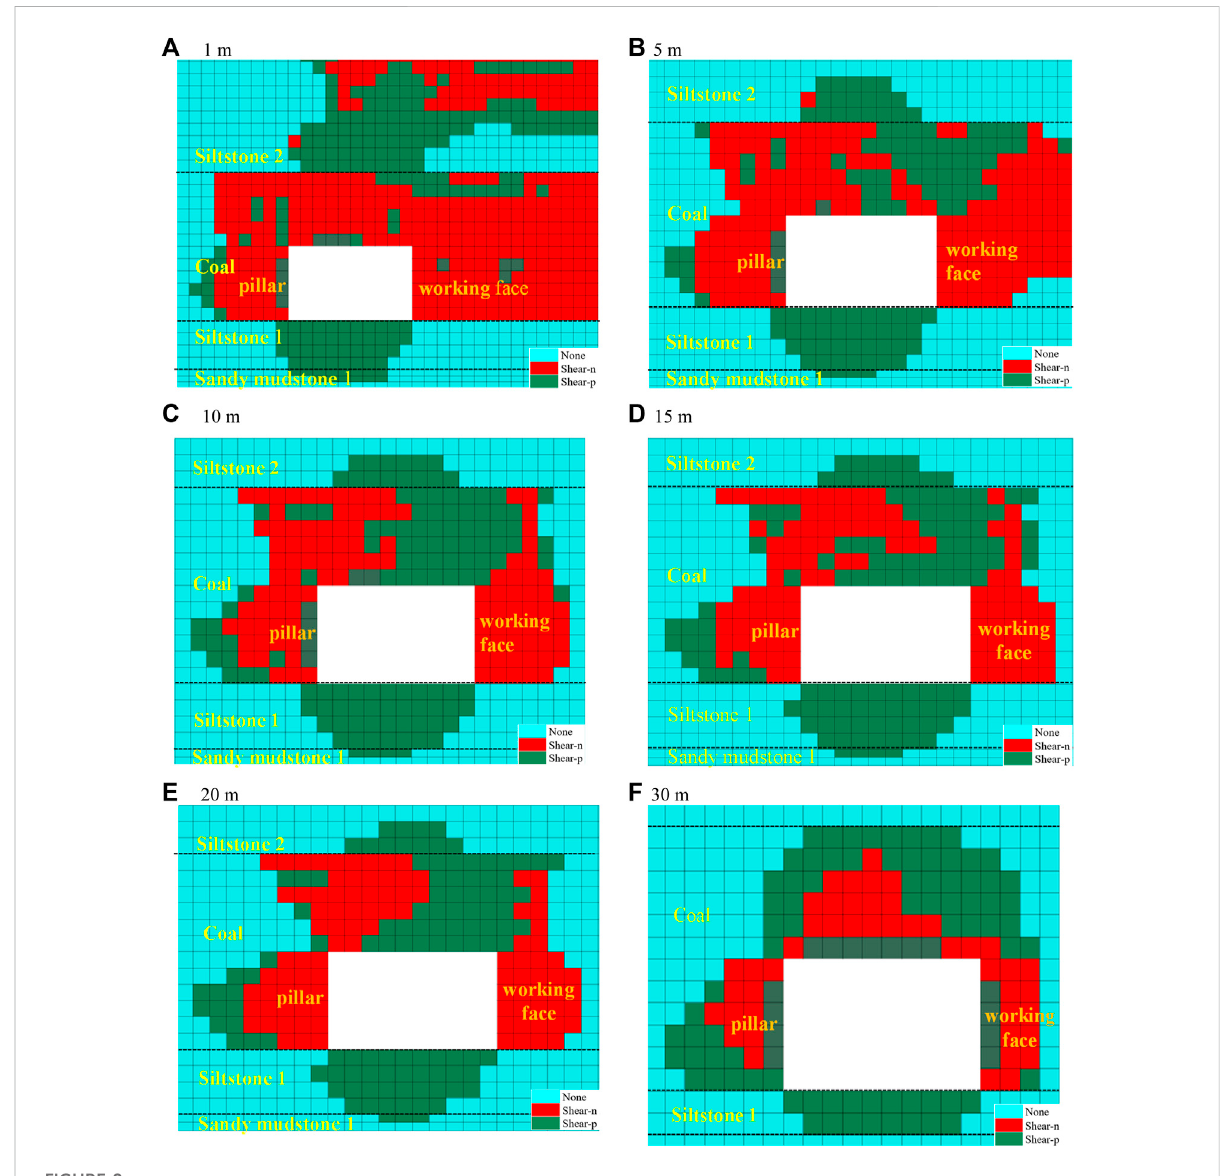
FIGURE 8 Failure characteristics of surrounding rock in the advance